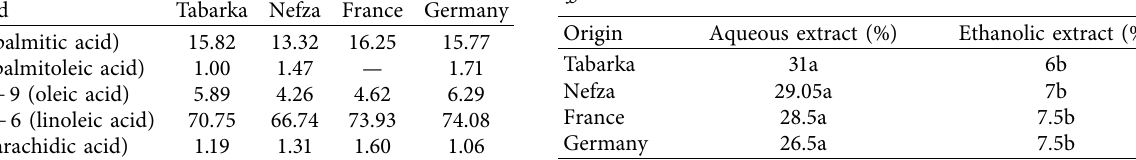
Table 6: Yield of aqueous and ethanolic extracts of Melissa officinalis .